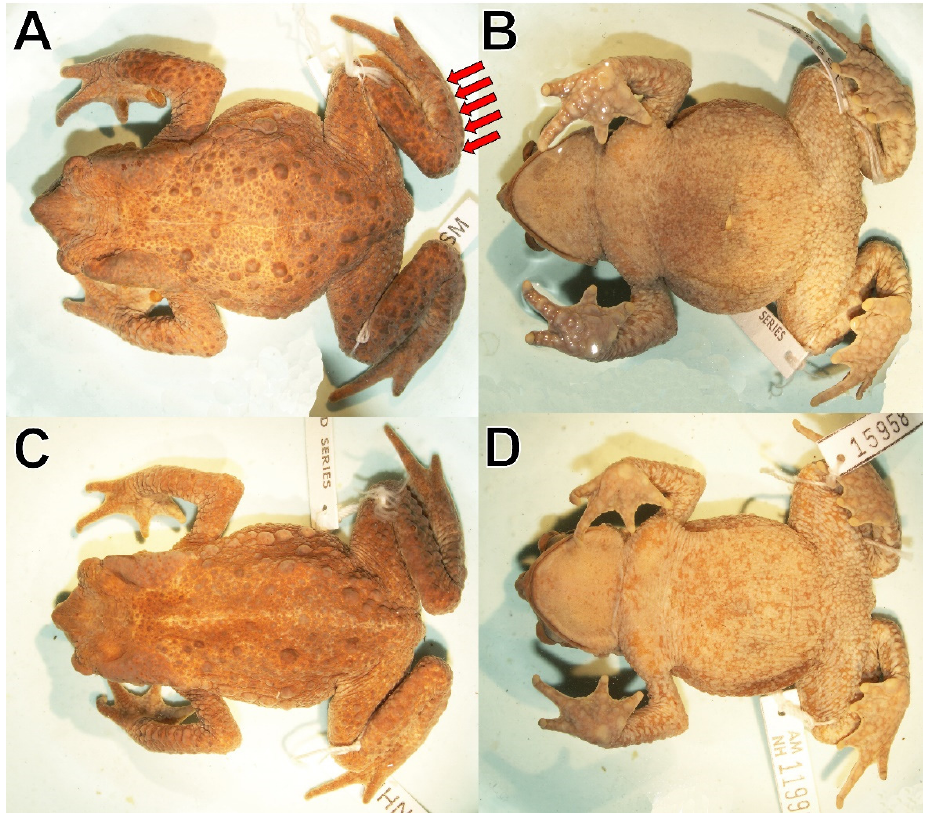
Figure 4. Holotype of Rhinella moralesi sp. nov. (MUSM 15959) in ( A ) dorsal, ( B ) ventral, and paratype of R. moralesi sp. nov. (MUSM 15958, SVL 57.6 mm, male) in ( C ) dorsal and ( D ) ventral views. Red arrows indicate ridge of fused tubercles on outer dorsolateral surface of tarsus. Photos by E. Lehr.